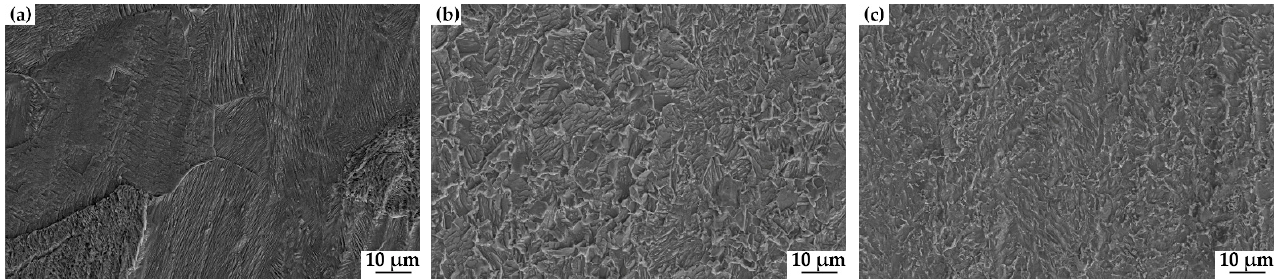
Figure 6. Corrosion rates of 20#, X60, and X80 steels determined from the weight-loss test after 14 days immersion.